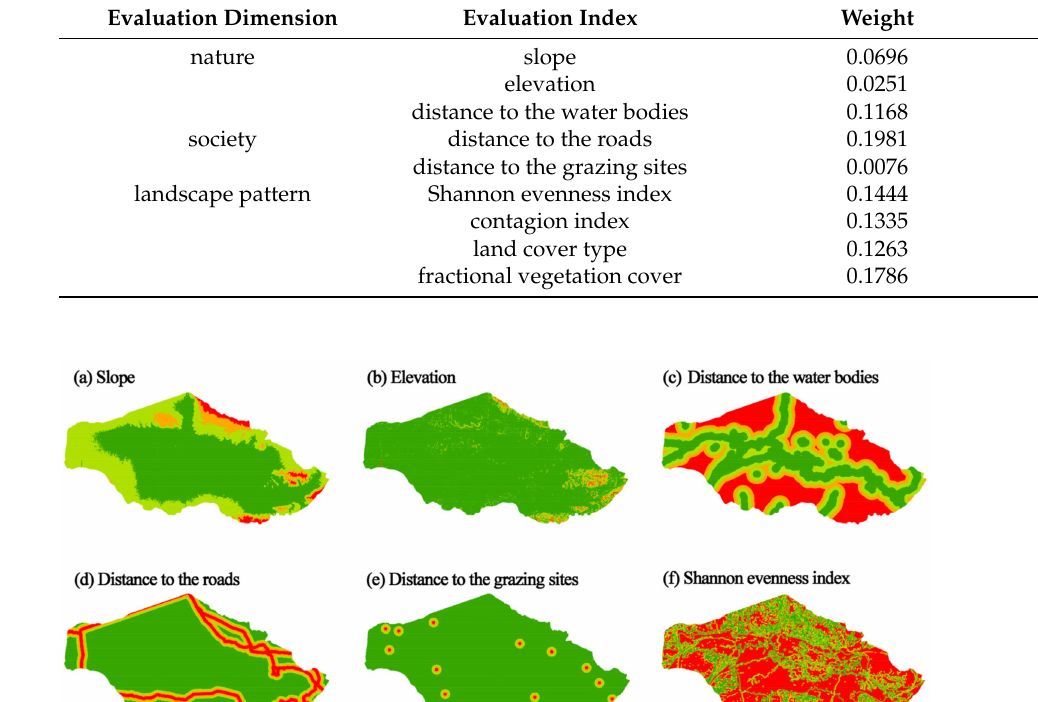
Table 4. Weight of index factors for landscape ecological risk assessment.